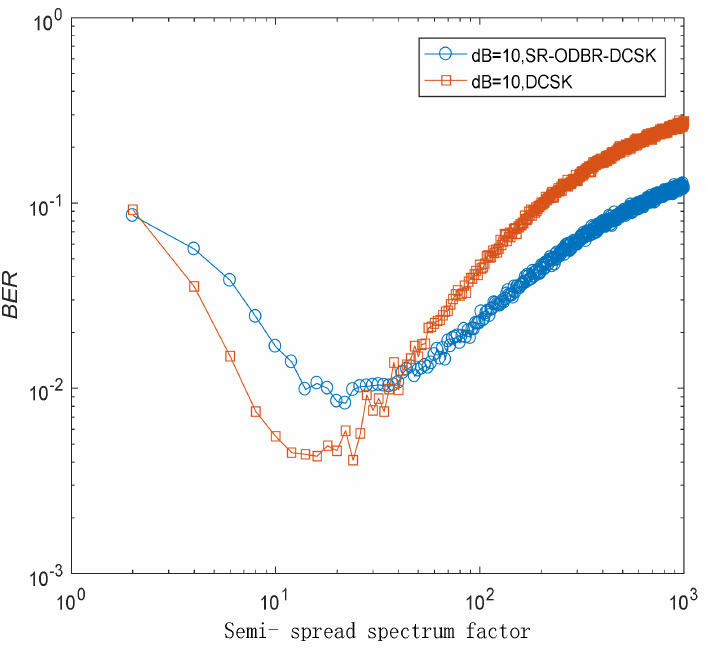
Figure 12. Relationship between semi-spread spectrum factor and bit error